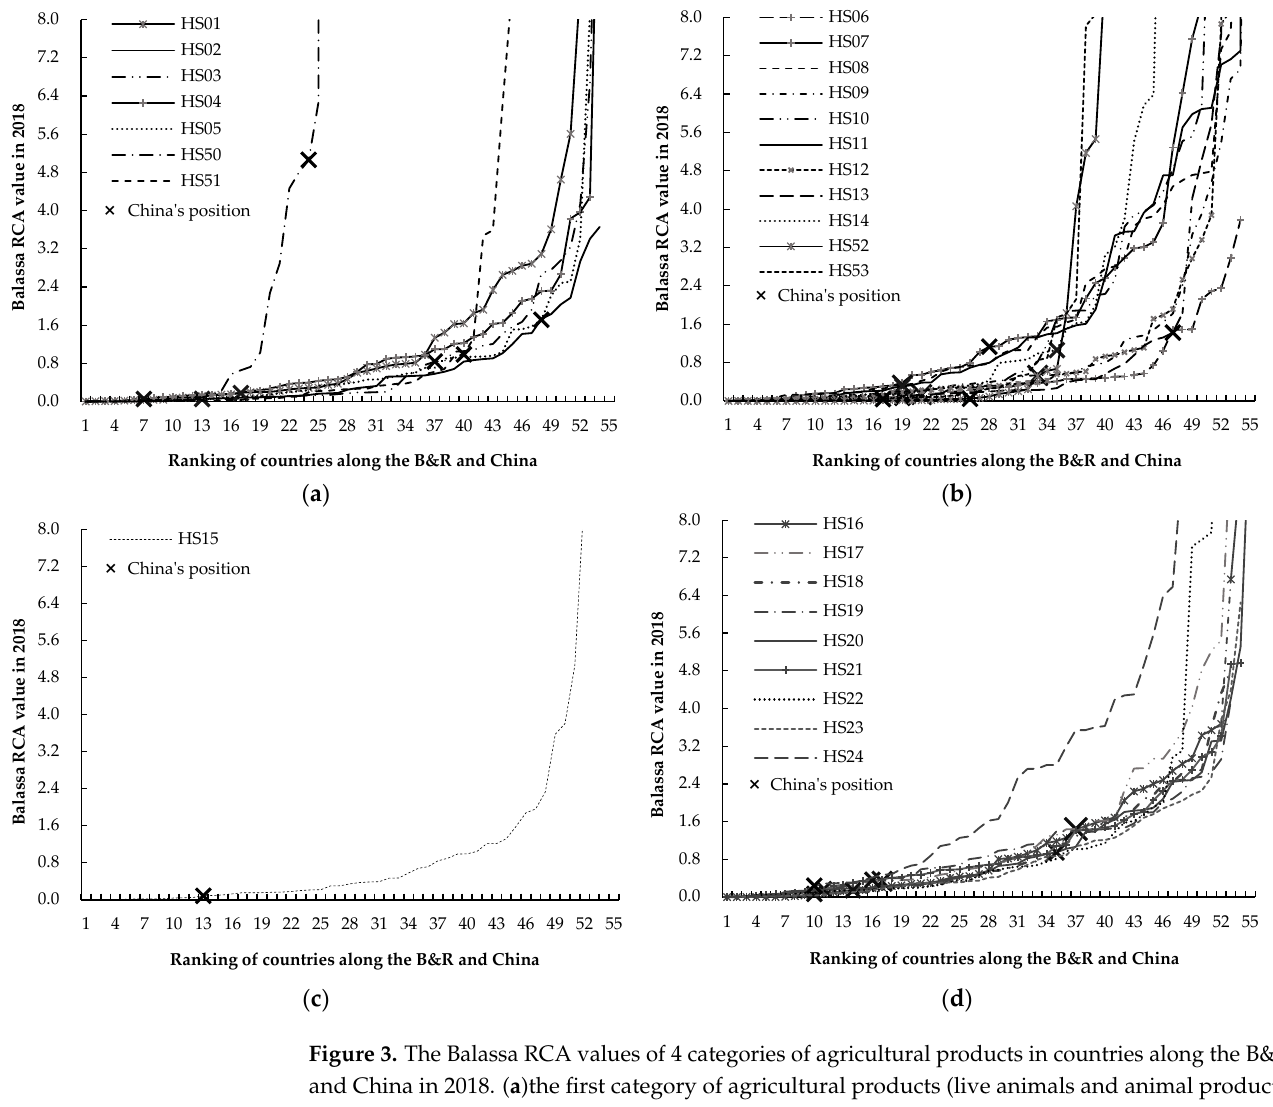
Figure 3. The Balassa RCA values of 4 categories of agricultural products in countries along the B&R and China in 2018. ( a )the first category of agricultural products (live animals and animal products, including HS01–HS05 and HS50–HS51); ( b ) the second category of agricultural products (plant products, including HS06–HS14 and HS52–HS53); ( c ) the third category of agricultural products (animal and vegetable oils and fats, including HS15); ( d ) the fourth category of agricultural products (food, beverages and tobacco, including HS16–HS24). The x -axis represents the ranking of countries along the B&R and China based on the Balassa RCA values in 2018; and the y -axis represents the Balassa RCA value.